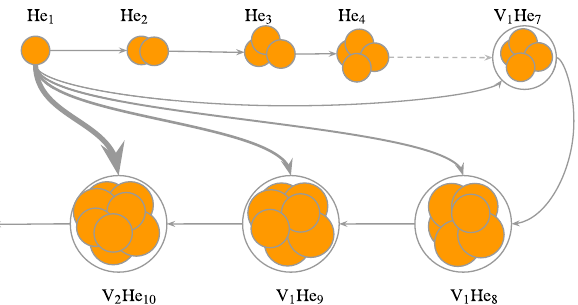
Figure 1. Representation of He clustering in solids. Dissociation is omitted for simplification purposes. The grey arrows thicknesses represent the magnitude of the reaction rate between mobile He 1 and other clusters at the same